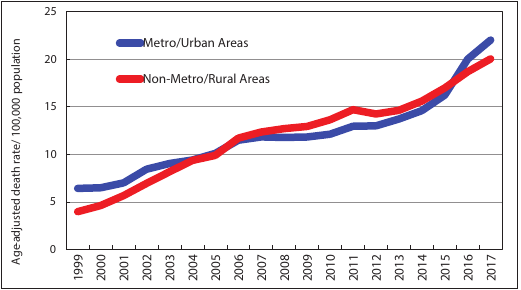
Figure 6: Trends in Suicide Mortality from Drug Overdose among Teens Aged 12-19 Years, United States, 1999-2017 Source: Data derived the National Vital Statistics System, Nation - al Mortality Database.